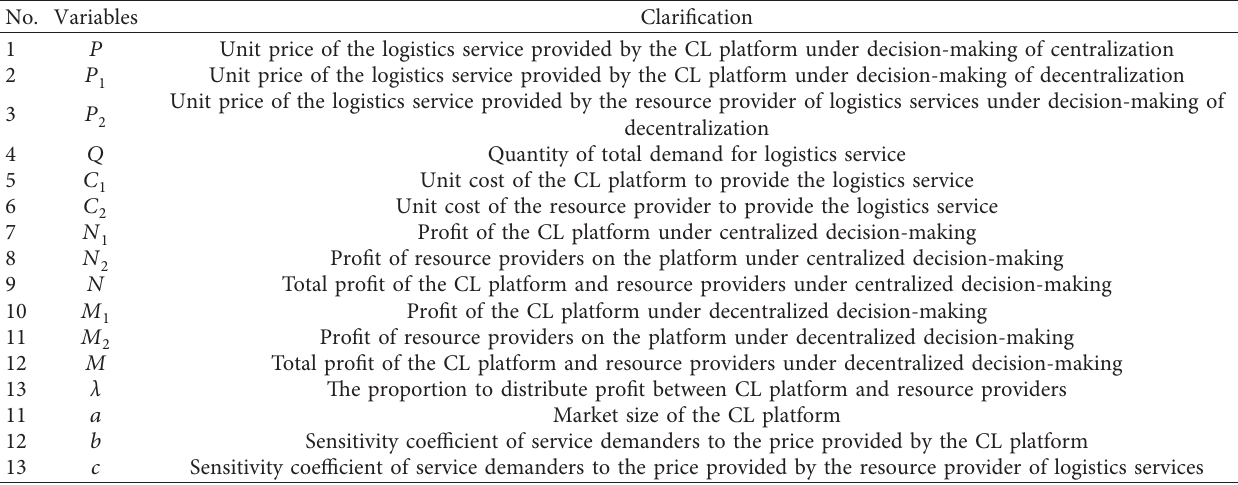
Table 1: Variables for the